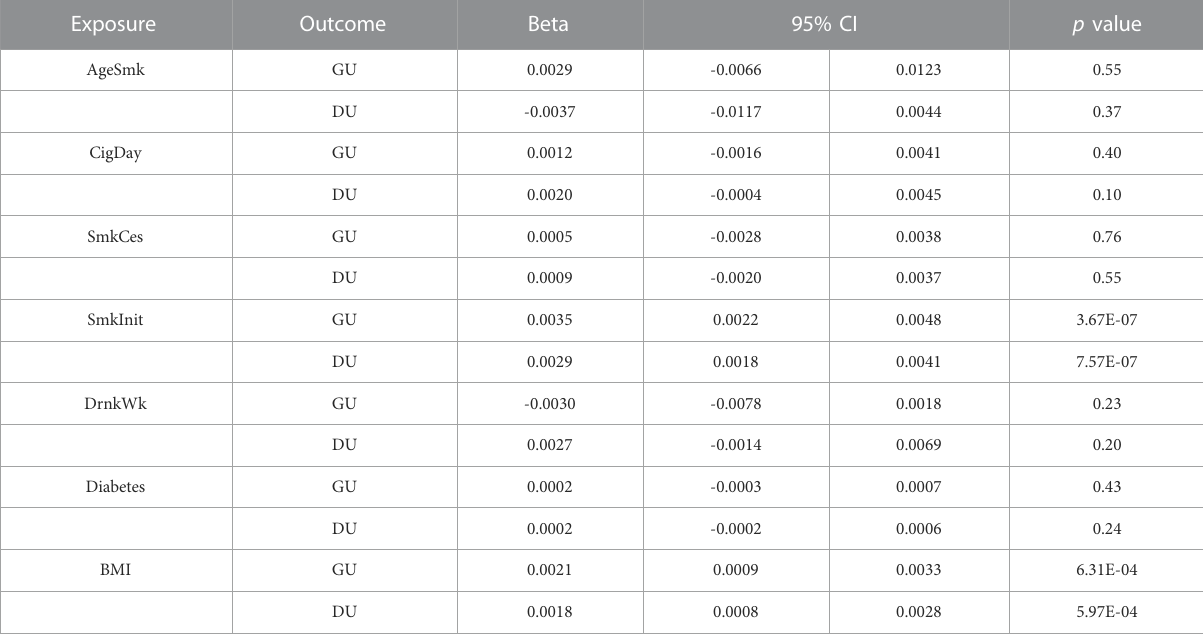
TABLE 2 Effect of the GRS instrument of smoking, alcohol consumption, diabetes, and BMI on GU, DU. Exposure